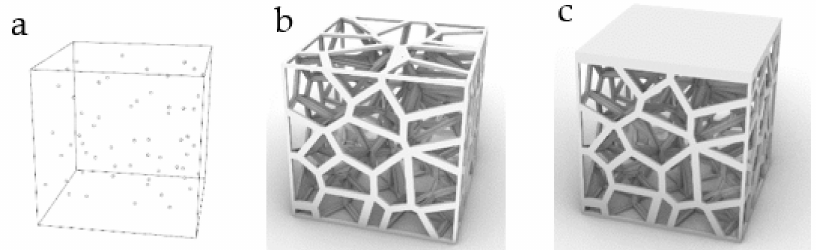
Figure 8. Structure 2: ( a ) Core points distribution; ( b ) Irregular porous structure; ( c ) Irregular porous structure with a thin plate.